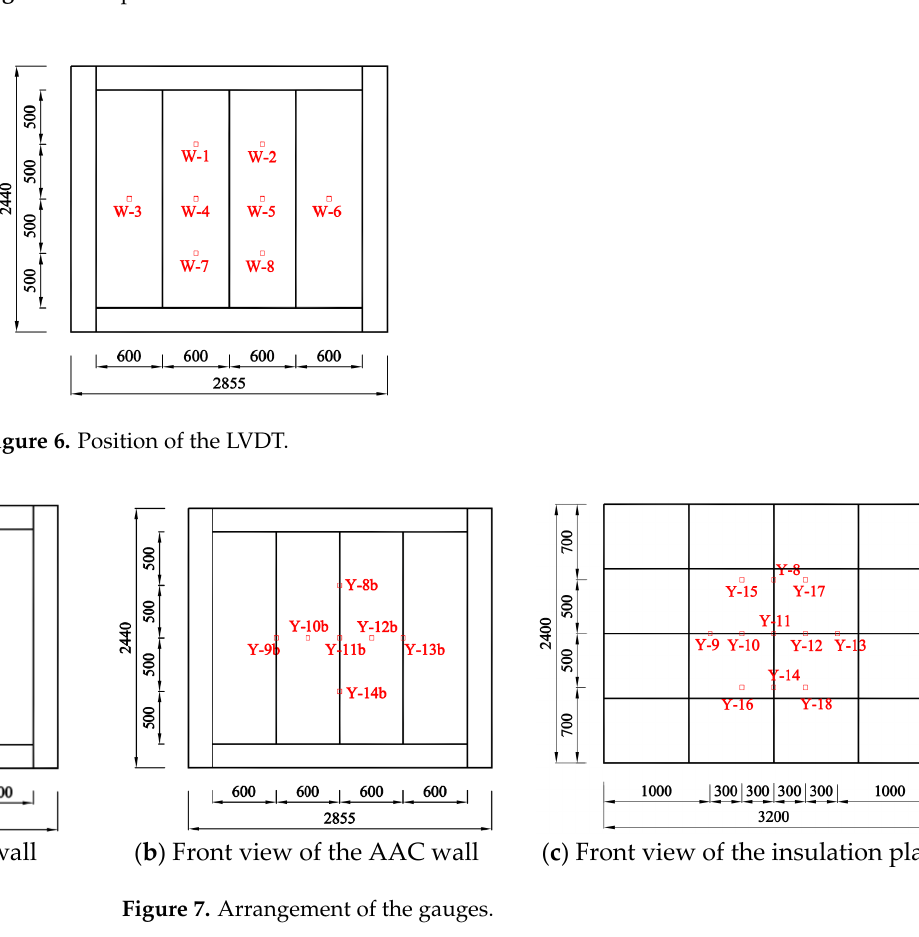
Materials 2021 , 14 , x FOR PEER REVIEW Figure 5. Setup for the wind suction test. Figure 5. Setup for the wind suction test.